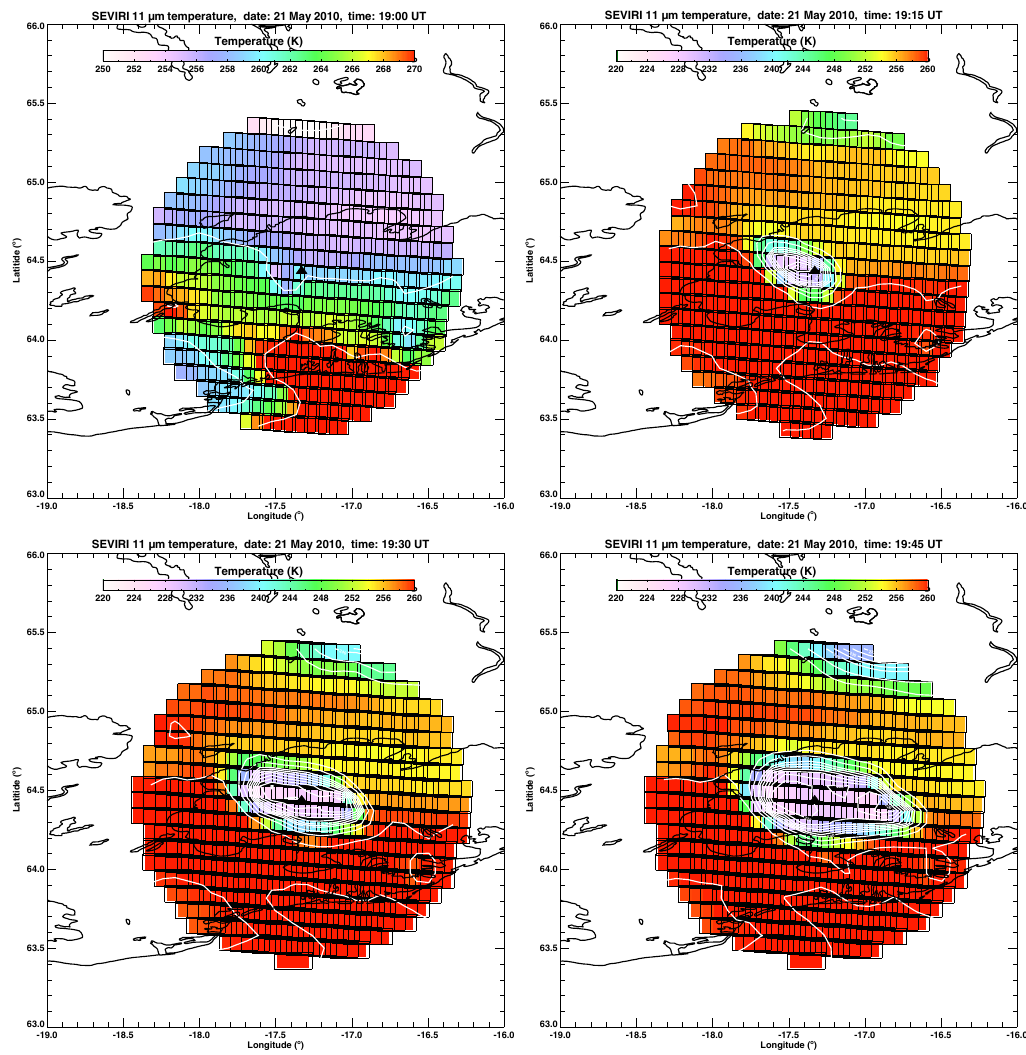
Figure 4. Close-up views of the 11µm brightness temperatures from the SEVIRI instrument at 15min intervals, starting at 19:00UTC on 21 May 2011. Isolines (contours) of brightness temperatures are shown in white to highlight the location and expansion of the top of the column. The rapid plume rise may be interpreted by the change in extent of the cloud-top temperatures. There is no evidence of an eruption in the image at 19:00UTC. The location of Grímsvötn is shown as a black